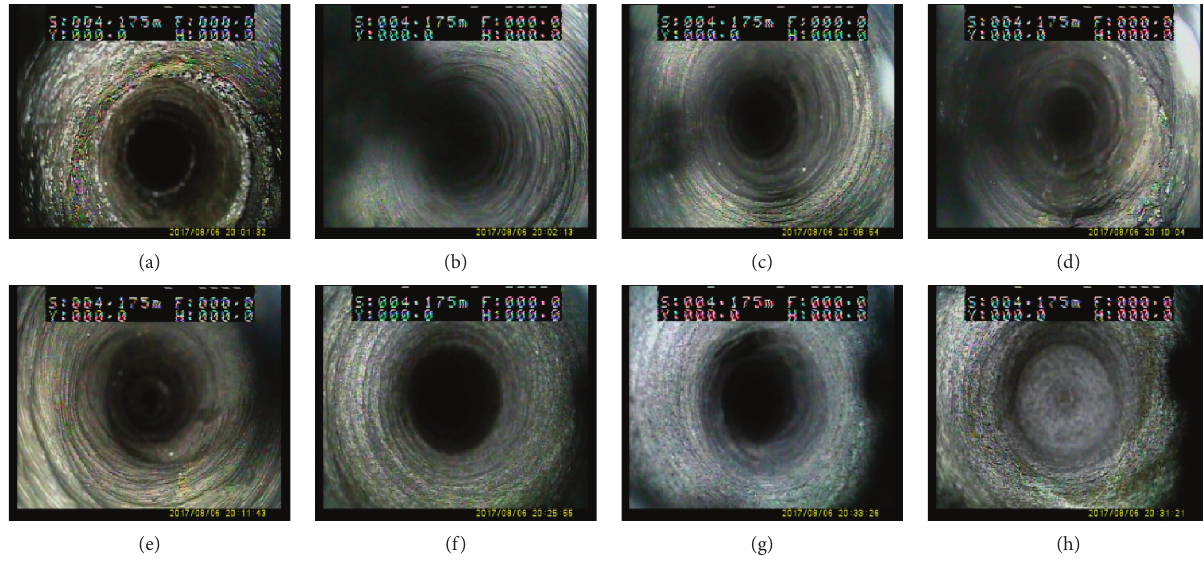
Figure 18: The distribution of the surrounding rock (2.8–10m) outside the anchor zone. (a) 2.9m. (b) 3.4m. (c) 4.0m. (d) 5.7m. (e) 6.4m. (f) 7.5 m. (g) 8.8m. (h)